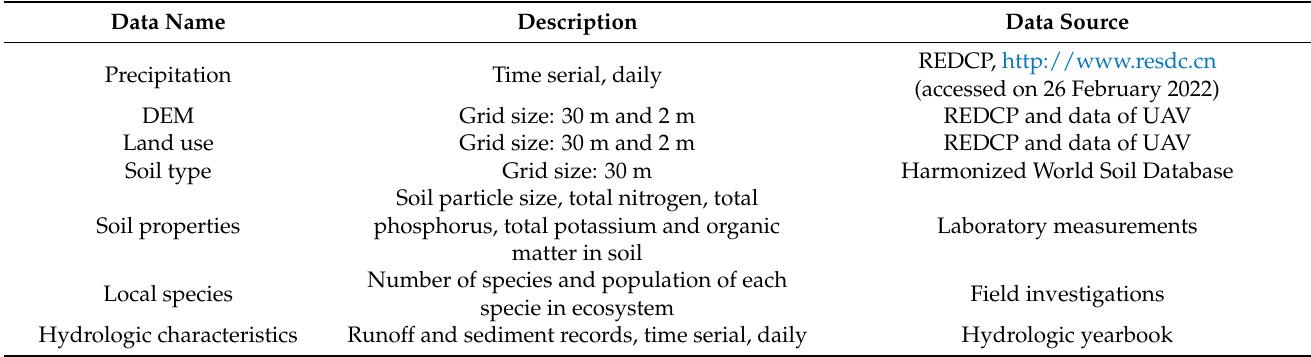
Table 1. Detailed description of the